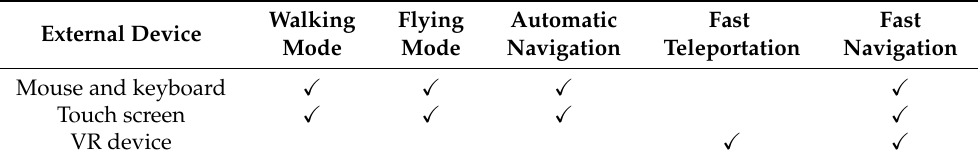
Table 2. The compatibility of roaming mode with external devices.